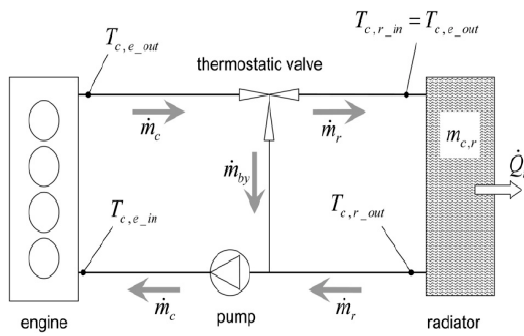
Figure 4. External cooling circulation.